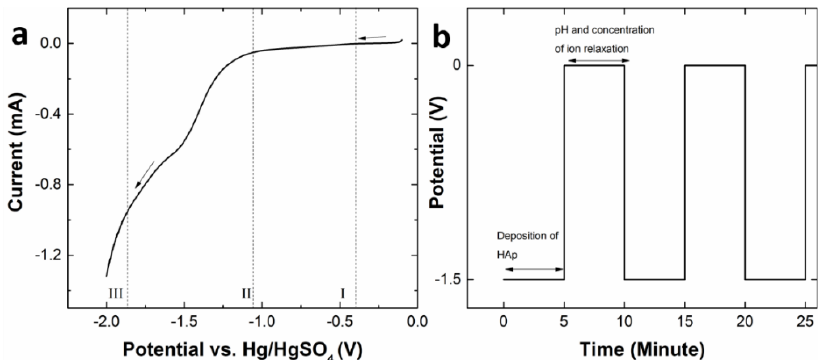
Figure 2. ( a ) Linear sweep voltammetry curve for hydroxyapatite (HAp) formation on stainless-steel (SS) 3D-woven lattice in an electrolyte containing 15 mM Ca(NO 3 ) 2 · 4H 2 O, 9 mM NH 4 H 2 PO 4 , and 30 mM NaNO 3 . The potential was swept from open-circuit potential (OCP) to − 2.0 V, at a rate of 20 mV / s and a temperature of 50 ◦ C. ( b ) Schematic diagram of deposition waveforms used in the electrodeposition coating process.